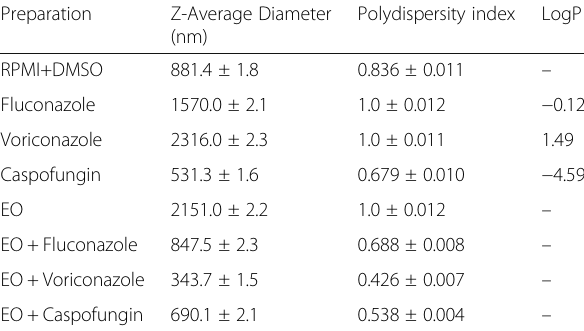
Table 4 Effect of the Pistachio Essential oil on droplet size (Z- Average Diameter) and emulsion polydispersity (Polydispersity index) in yeast culture medium